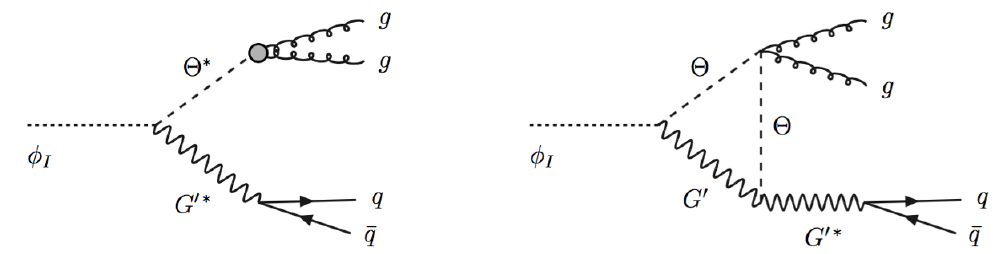
I ! ggq (cid:22) q of the CP -odd scalar when